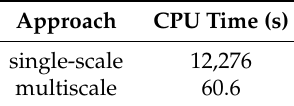
Table 5. Stiffened fuselage section problem: computational